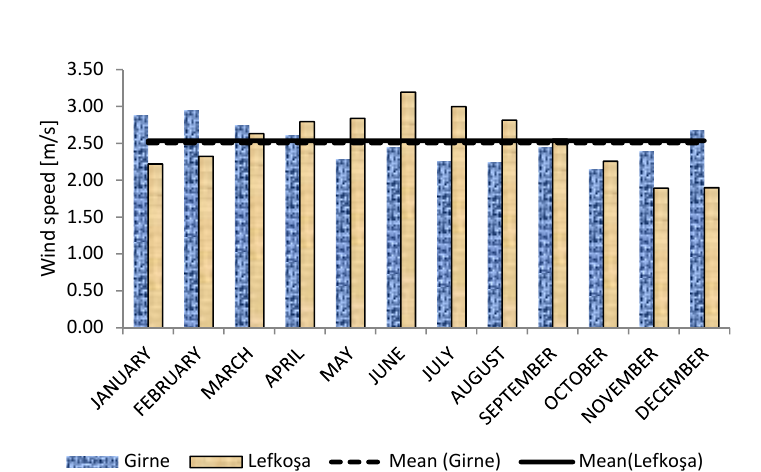
Fig. 3: Monthly mean wind speed in m/s for all years